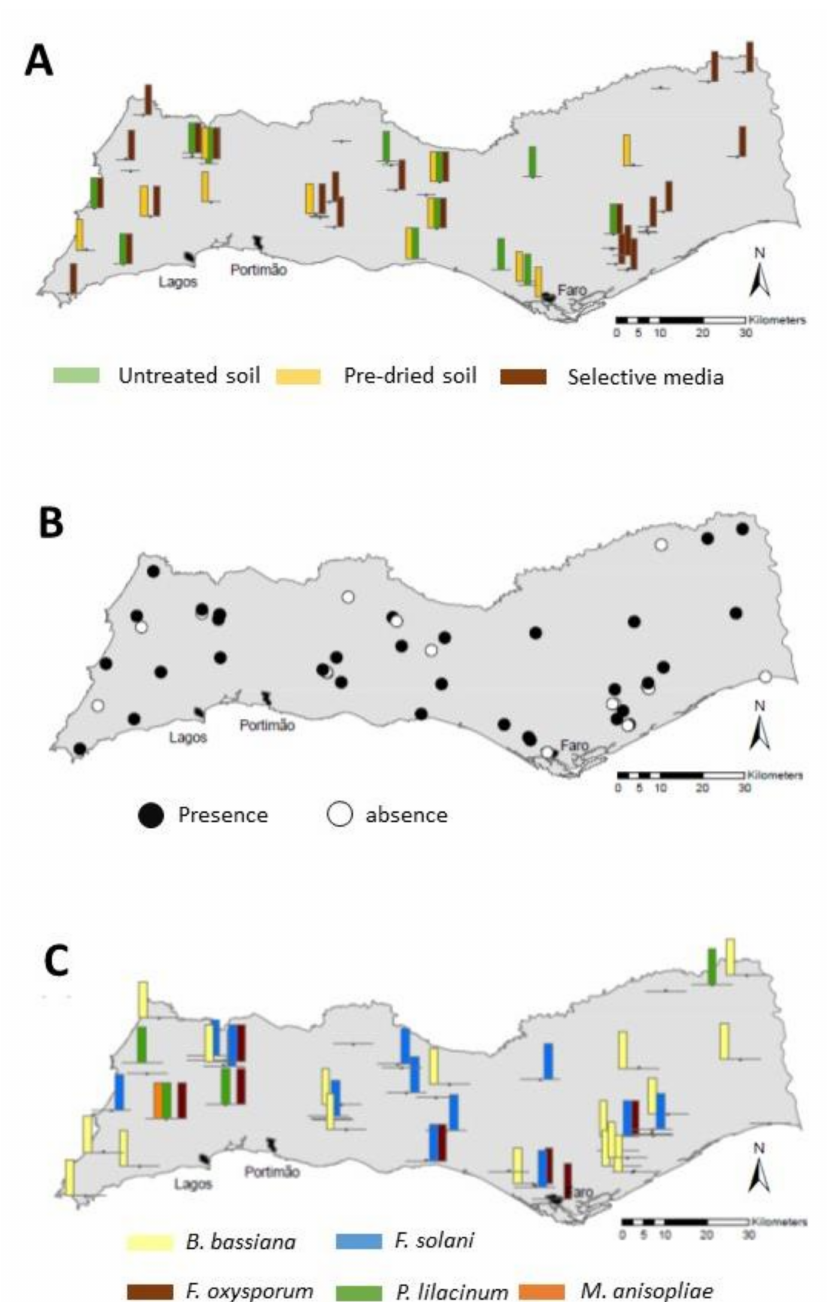
Figure 3. Geographical distribution for entomopathogenic fungi (EPF) occurrence in the region of Algarve (Southern Portugal) ( A ) Positive sites for each isolation method; ( B ) positive sites for any isolation method; ( C ) distribution of EPF